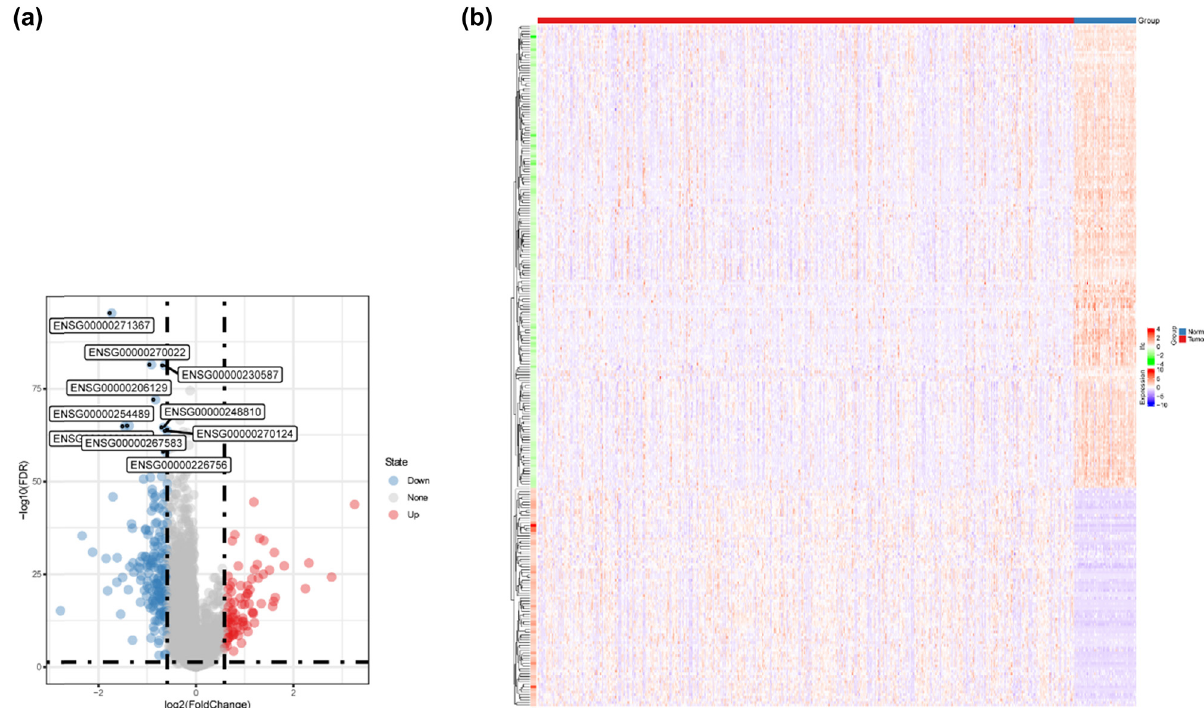
Figure 2: Comparison of lncRNAs expression in PTC tissues with adjacent tissues. ( a ) Volcano plot. The top ten DElncs were indicated based on the FDR, which were all downregulated. ( b ) Heatmap plot. Note: lfc, log2 ( FC )